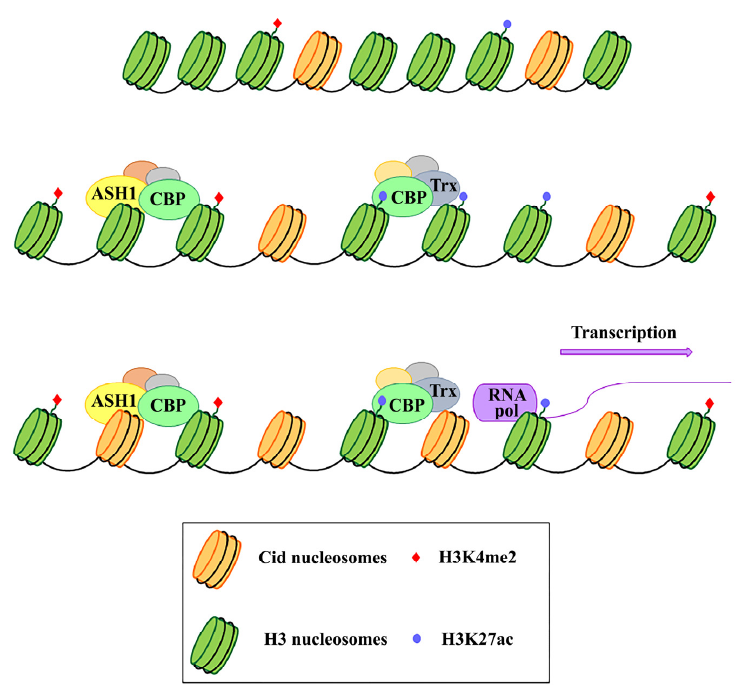
Figure 1. Schematic representation of the functional role of Ash1, CBP, and Trx proteins in the centromeric region. These proteins work by modifying the epigenetic state of the centromeric chromatin. In particular, on H3 histones, Ash1 dimethylates lysine 4 (H3K4me2) and CBP acetylates lysine 27 (H3K27ac) within the centromeric region. Trx works by inducing chromatin opening which, in turn, favours both CENP-A/Cid deposition and activation of transcription.